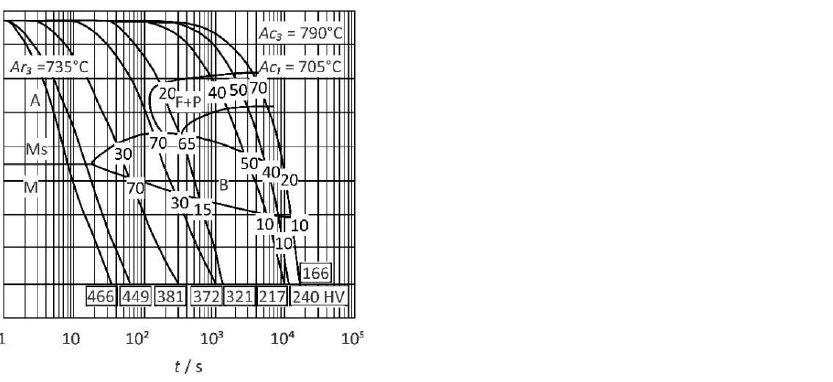
Figure 1. CCT diagram for 18CrNiMo7-6 steel. Redrawn from the material data sheet [33].